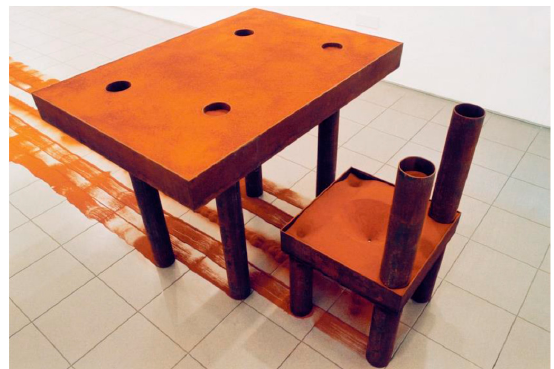
Figure 9. Micha Ullman, Map , 2002. Sand installation; Iron and red sand. Table: 110 cm × 78 cm, height: 85 cm; Chair: 45 cm × 45 cm, height: 85 cm; Dragging backward: 5–9 m. Photograph: Avraham Hay.